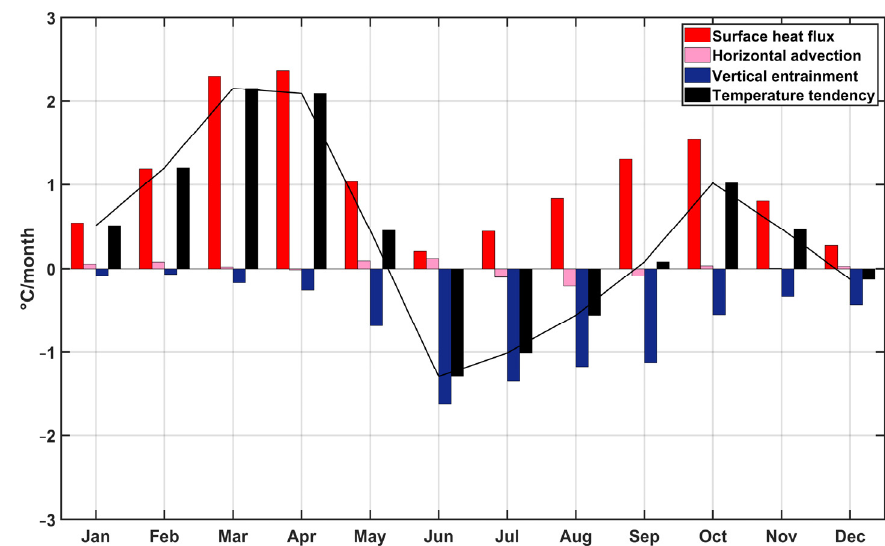
Figure 11. Monthly climatological variation of heat budget terms (°C/month) averaged in the SEAS.